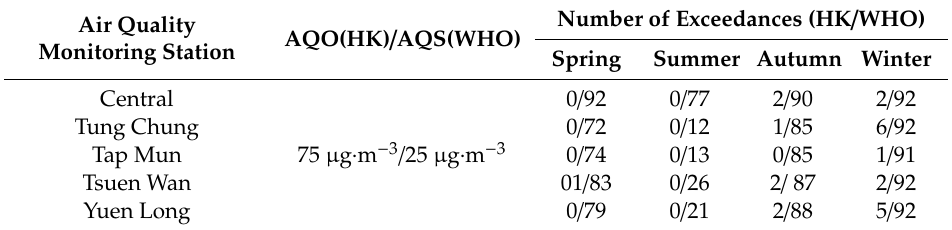
Table 2. The total number of exceedances of daily mean fine particulate matter (PM 2.5 ) mass concentrations in di ff erent seasons from 2005 to